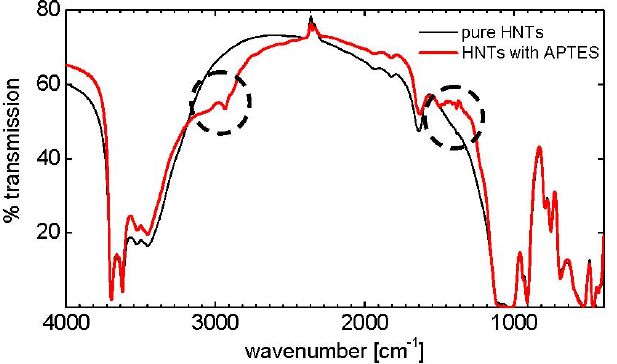
Figure 1. FTIR spectra of pure HNTs (thin black line) and APTES functionalized HNTs (thick red line, color online). Dashed circles indicate bands originating from